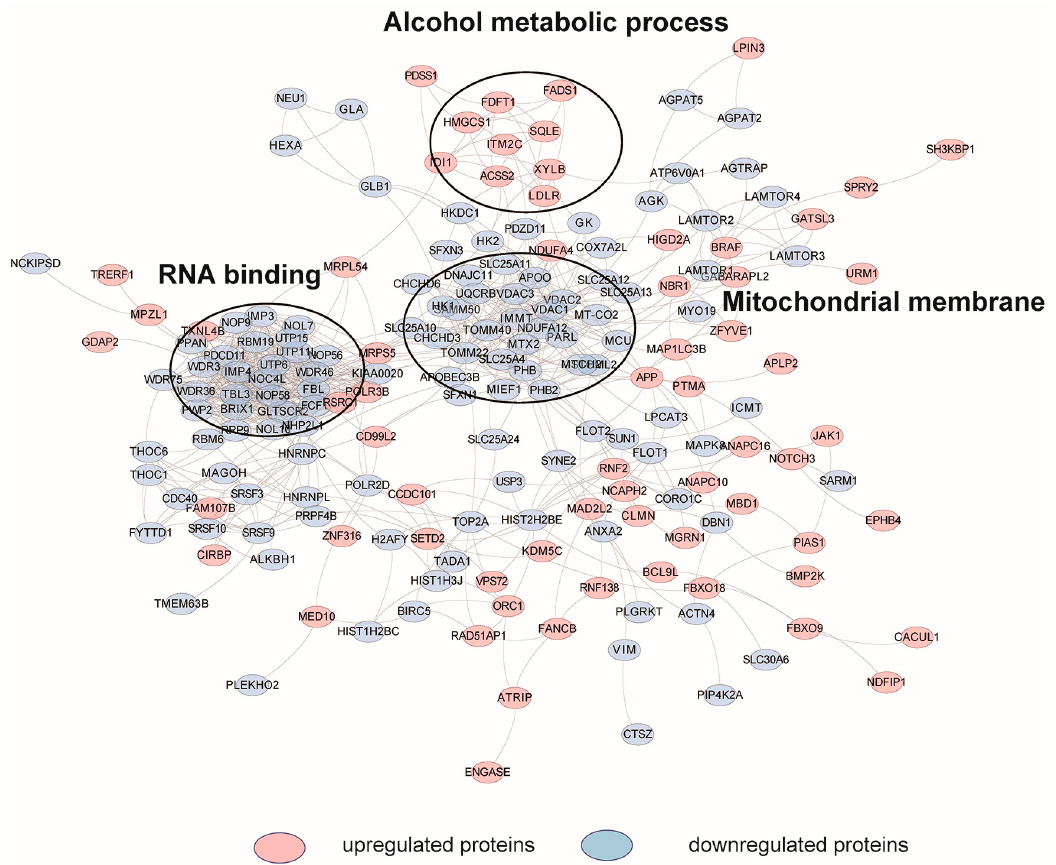
Figure 5. Interaction network of the differentially expressed proteins induced by HCQ, based on STRING database. The network is visualized in Cytoscape. Red color represents the upregulated proteins and blue color represents the downregulated proteins.